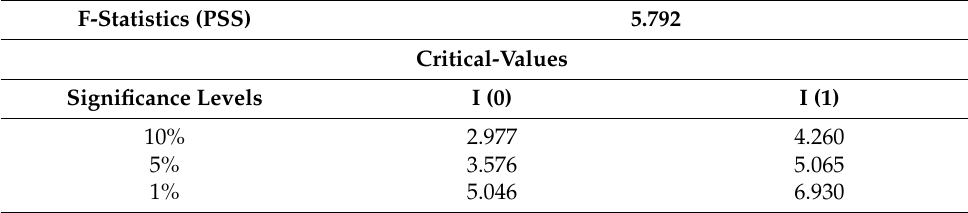
Table 3. Result of NARDL Bound Test.